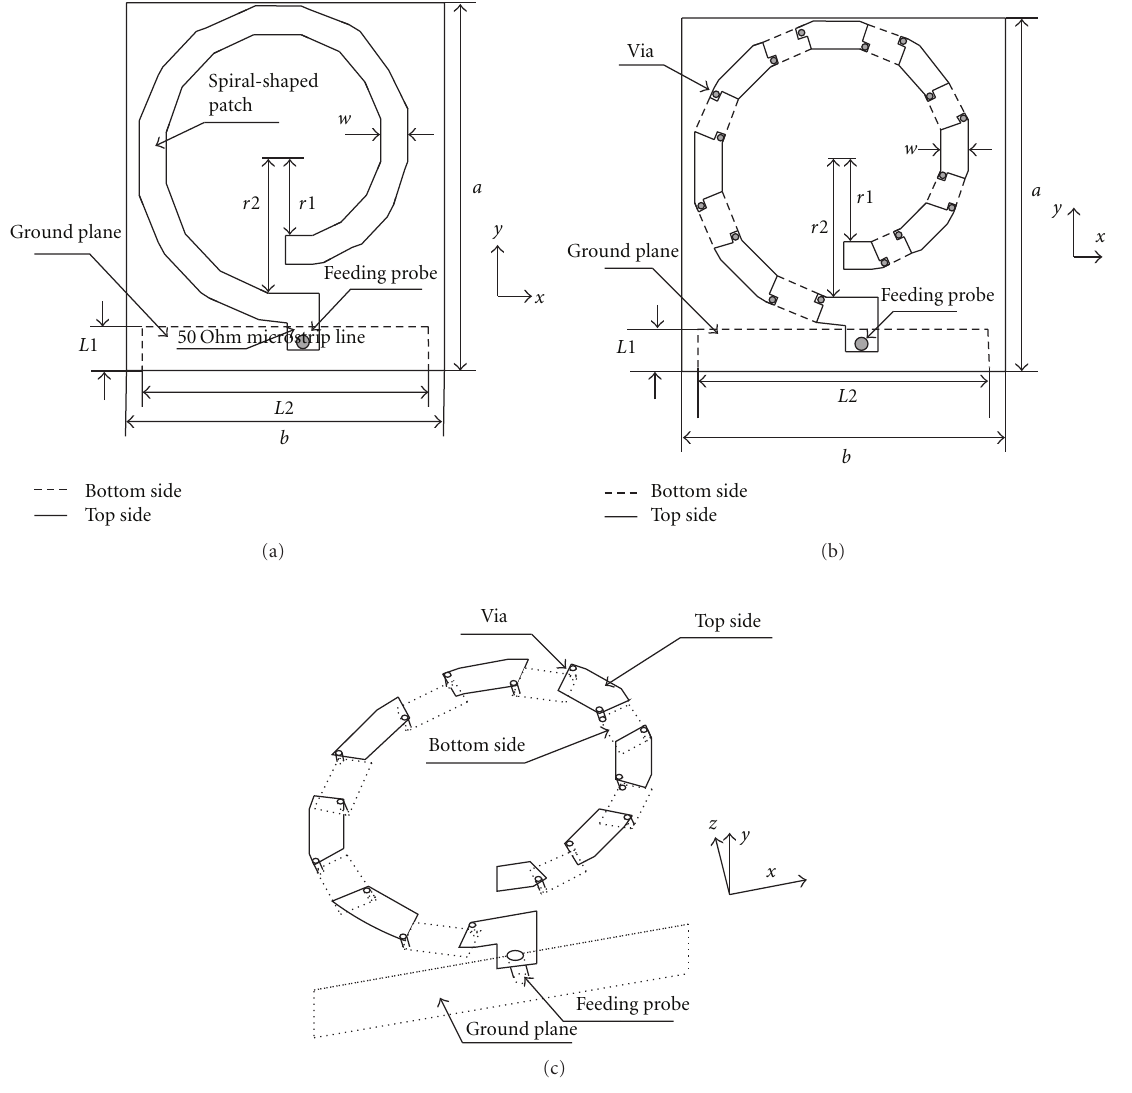
Figure 1: (a) Top view of the conventional printed spiral antenna. (b) Top view of the novel printed spiral antenna. (c) 3D view of the novel